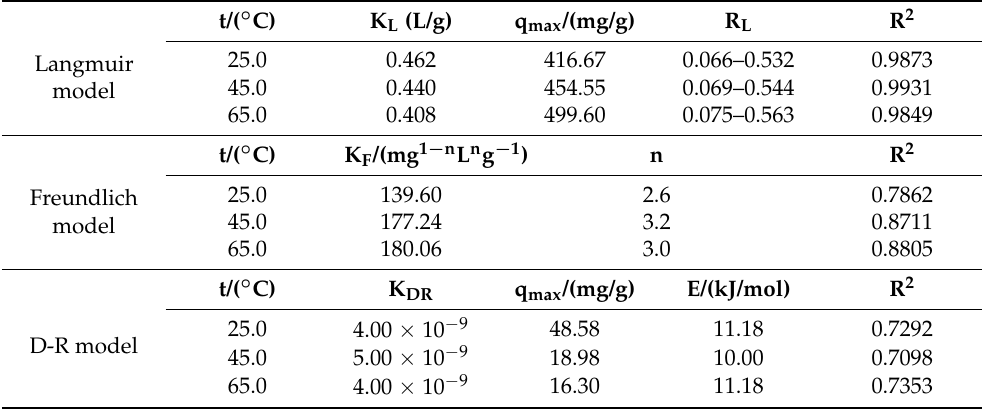
Table 4. The constants of Langmuir model, Freundlich model, and D-R model.